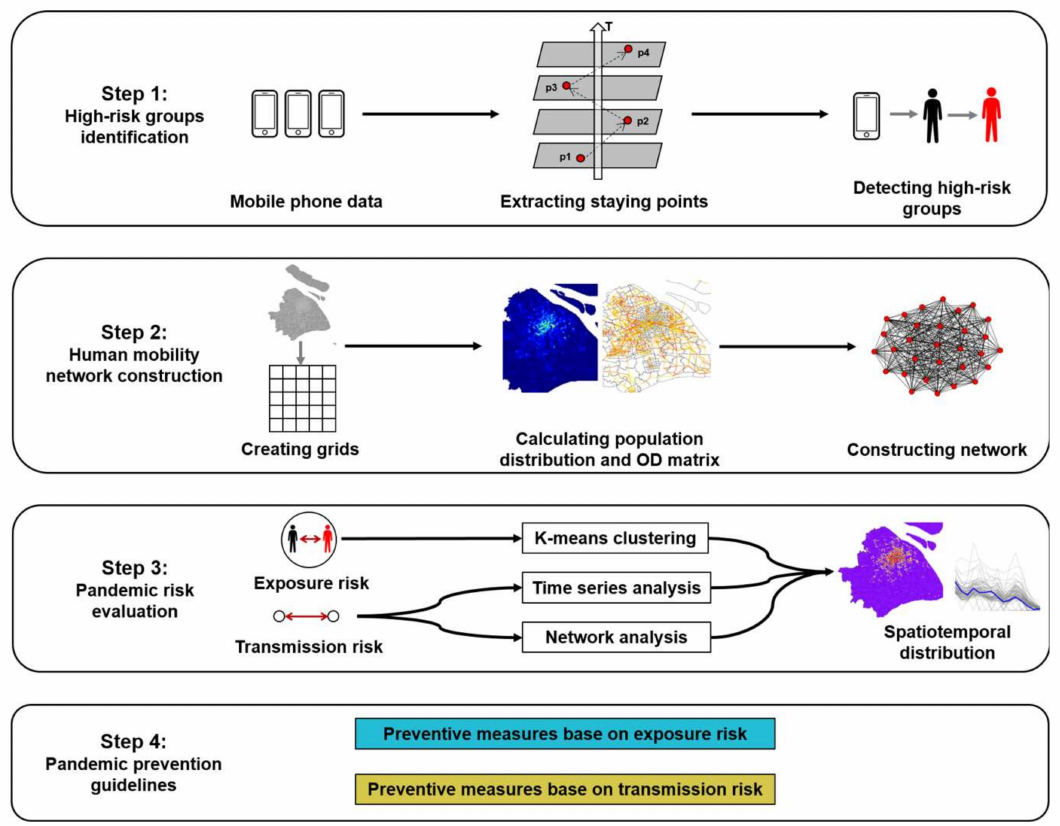
Figure 1. Framework of the